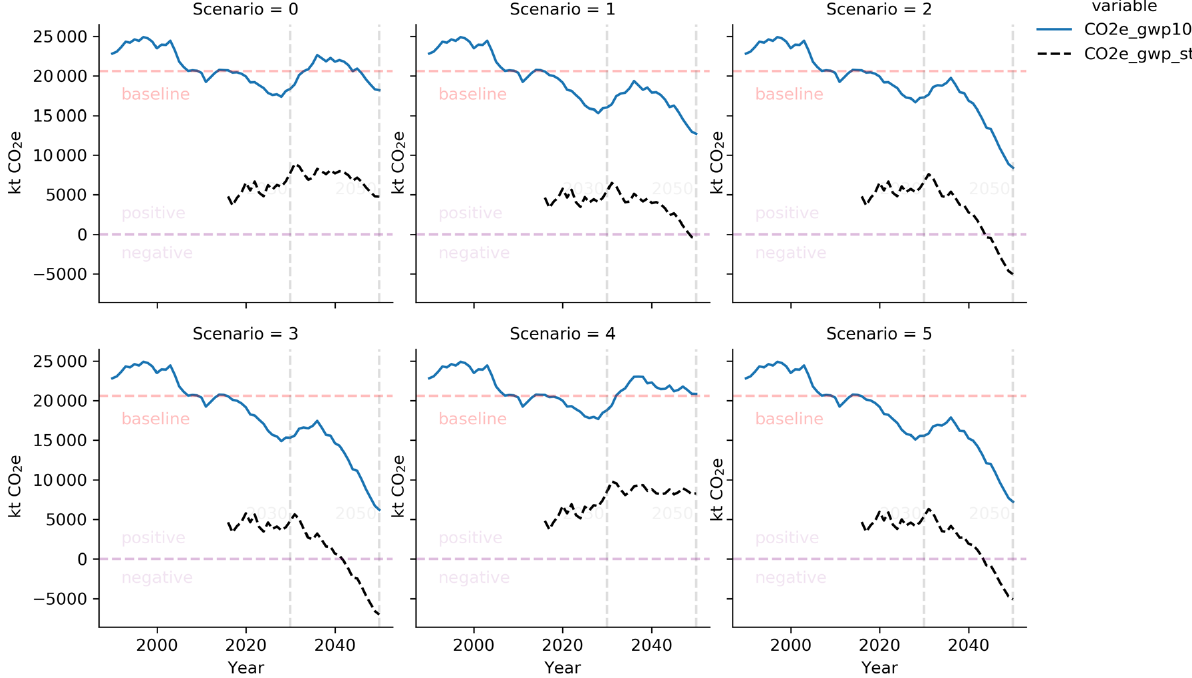
Figure 12. GOBLIN scenario GHG balance through time based on CO 2 aggregation using GWP 100 and GWP ∗ . Blue lines represent GWP 100 , and the black line represents the GWP ∗